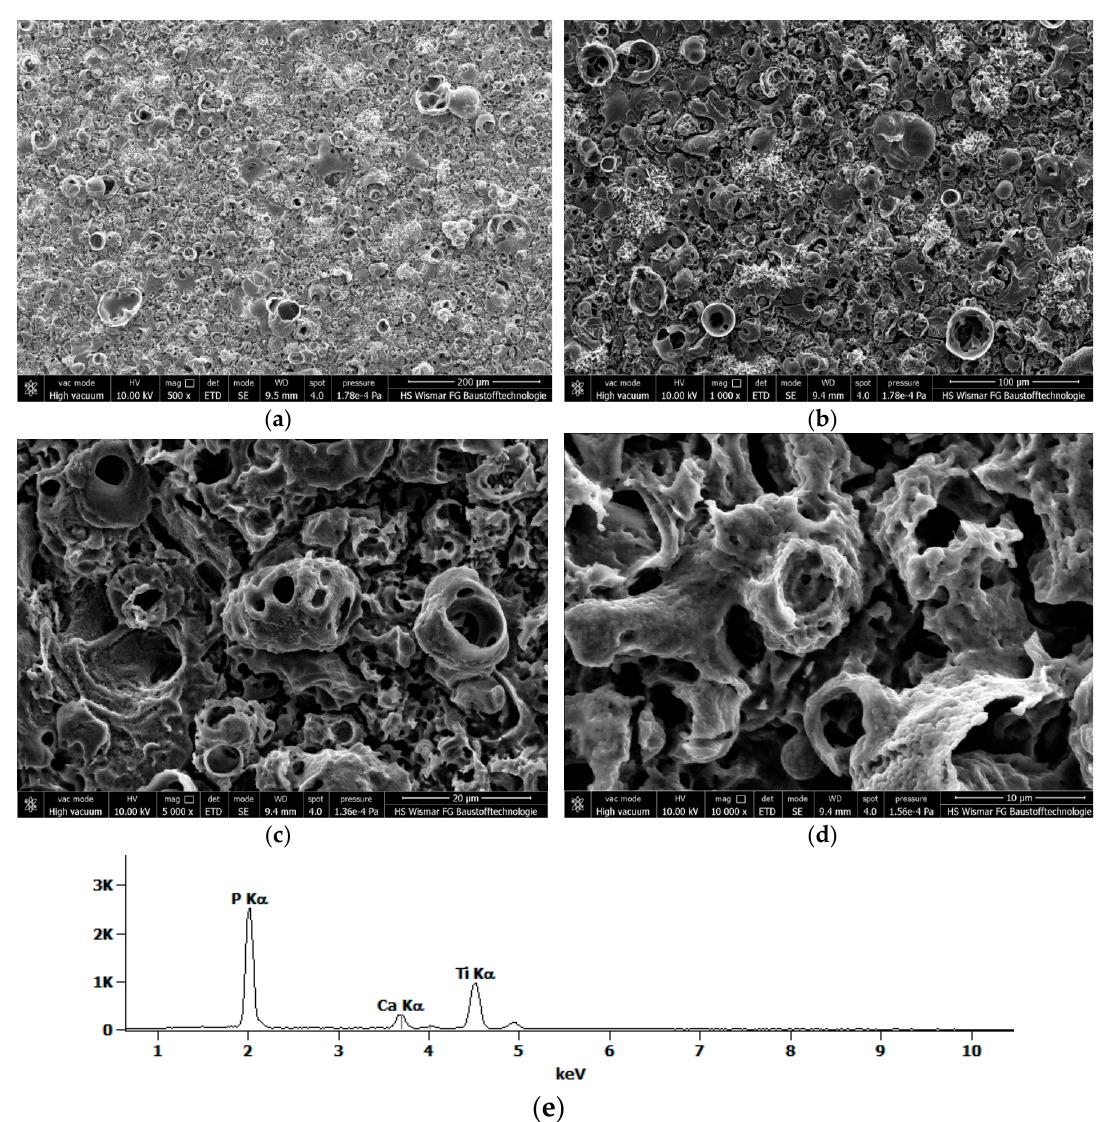
Figure 7 . SEM pictures ( a – d ) and EDS spectrum ( e ) of the porous coating formed on CP Titanium Grade 2 after PEO treatment at a voltage of 550 V DC in 500 g Ca(NO 3 ) 2 ·4H 2 O in 1000 mL H 3 PO 4 electrolyte. Magnifications: ( a ) 500×, ( b ) 1000×, ( c ) 5000×, ( d ) 10,000×.